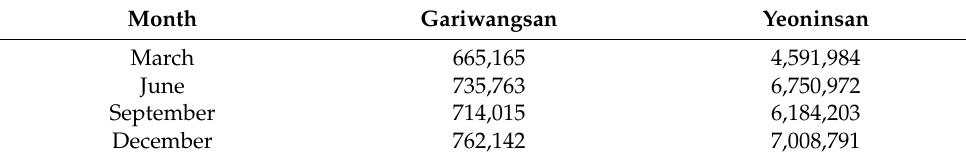
Table 7. Number of floating populations in Gariwangsan and Yeoninsan (no. of people).